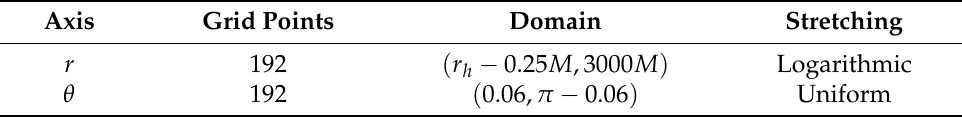
Table 2. Details on the numerical grid adopted. Here r h (cid:39) M is the event horizon radius. Axis